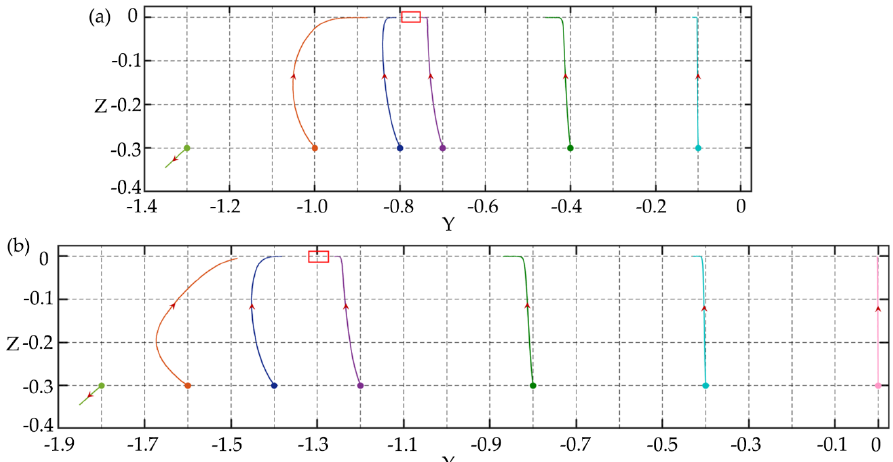
Figure 7. The migration trajectories of particles with d / h =0.15 in channels with different aspect ratios: ( a ) AR = 1/3 under Re = 2.5 and Wi = 0.2; ( b ) AR = 1/4 under Re = 2.5 and Wi = 0.2. The red boxes in the ( a ) AR = 1 / 3 under Re = 2.5 and Wi = 0.2; ( b ) AR = 1 / 4 under Re = 2.5 and Wi = 0.2. The red boxes in